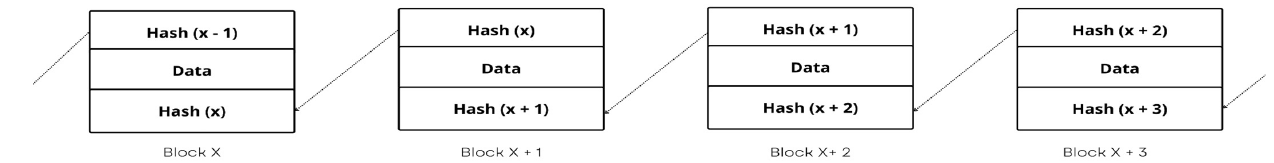
Figure 7. Blocks are linked together in a blockchain using a cryptographic hash. x is an arbitary block, x + 1 is a suceeding block and so on.